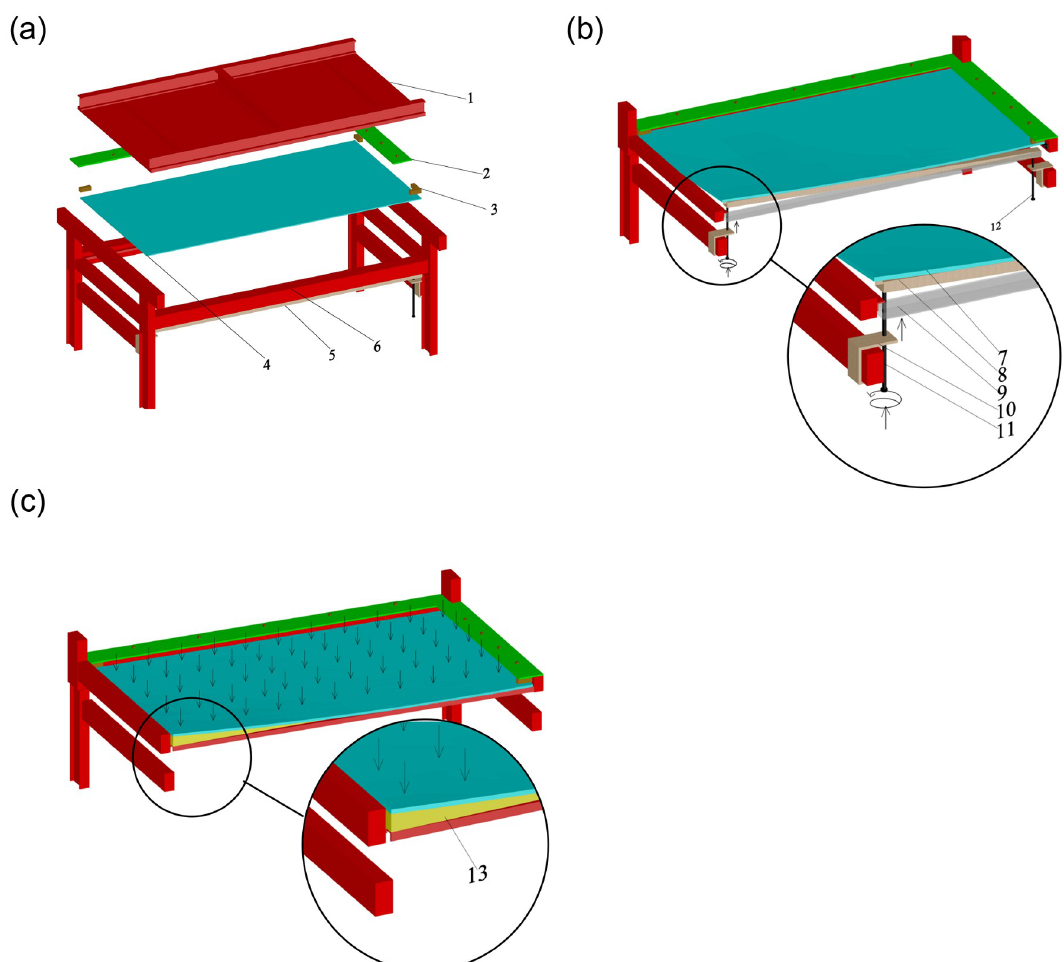
Fig 2. Test device. (a) The assembly of the cold bending device. (b) Schematic diagram of the cold bending process. (c) Schematic diagram of the uniform load test. The symbols in figures stand for: 1. Reaction frame, 2. Fixed steel plate, 3. Timber block, 4. Glass, 5. Cold bending loading device, 6. Support frame, 7. Glass, 8. Square steel pipe (final position), 9. Square steel pipe (initial position), 10. Fixed buckle, 11. Long screw (cold bending end), 12. Long screw (fixed end), 13. Wedge-shaped inclined brace. bending tests and uniform load tests for frame-supported glass panels. Fig 2(a) was the assem- bly diagram of the test device, which consisted of a load reaction frame, a steel plate fixture and a support frame for glass plate and cold bending loading device. Among them, the cold bending loading device was specifically designed for glass plates, which was composed of a square steel pipe, long screws and fixed buckles. Two ends of the square steel pipe were con- nected with a long screw by two fixed buckles, which were located on the support frame as shown in Fig 2(b). Furthermore, the load reaction frame could be removed and cut along the free long edge of the sample plate for better observation. Installed under the long edge of the sample plate, one end of the load reaction frame was placed below the cold bending corner, while the other was located beneath the fixed corner. Both ends were fixed to the short beam at the bottom of the support frame with fixed buckles that connect the long screw and the steel pipe, so that the latter can move up and down freely and be lifted into contact with the glass after the sample was fixed on the supporting frame. Then the square steel pipe at the fixed